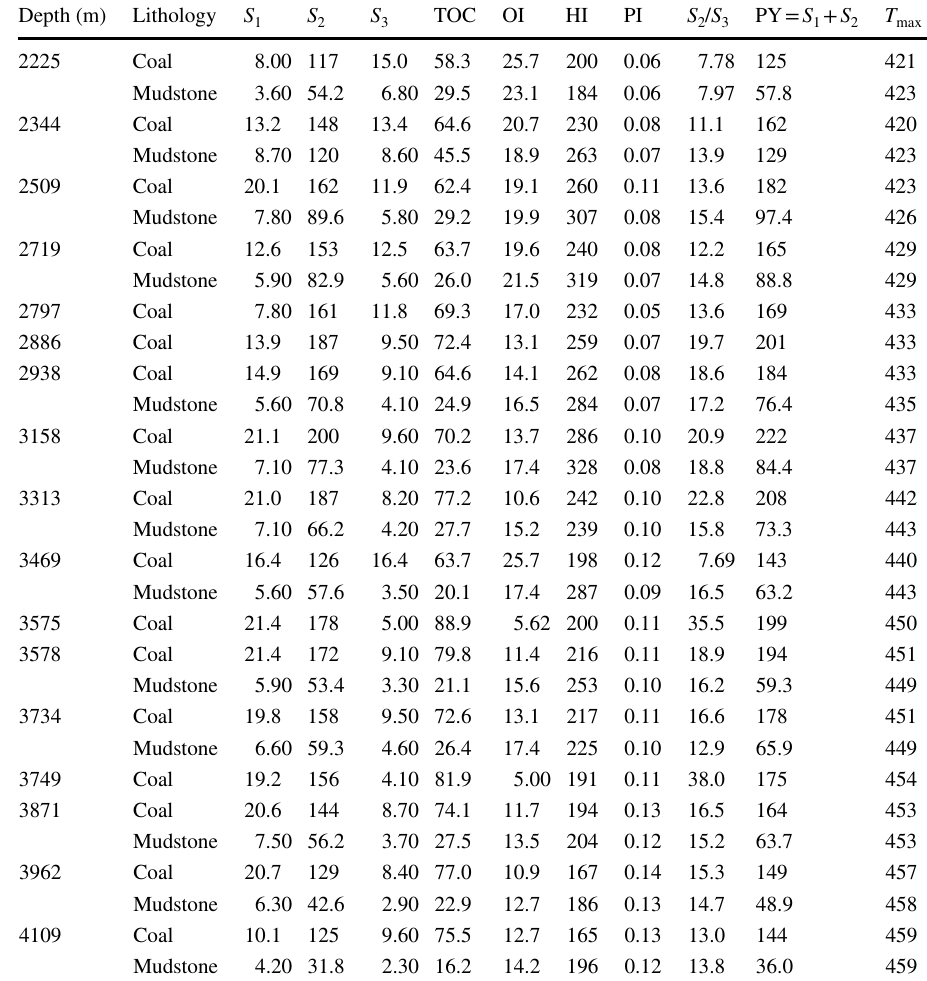
Table 1 Results of Rock-Eval pyrolysis from Tara-1 well used in this